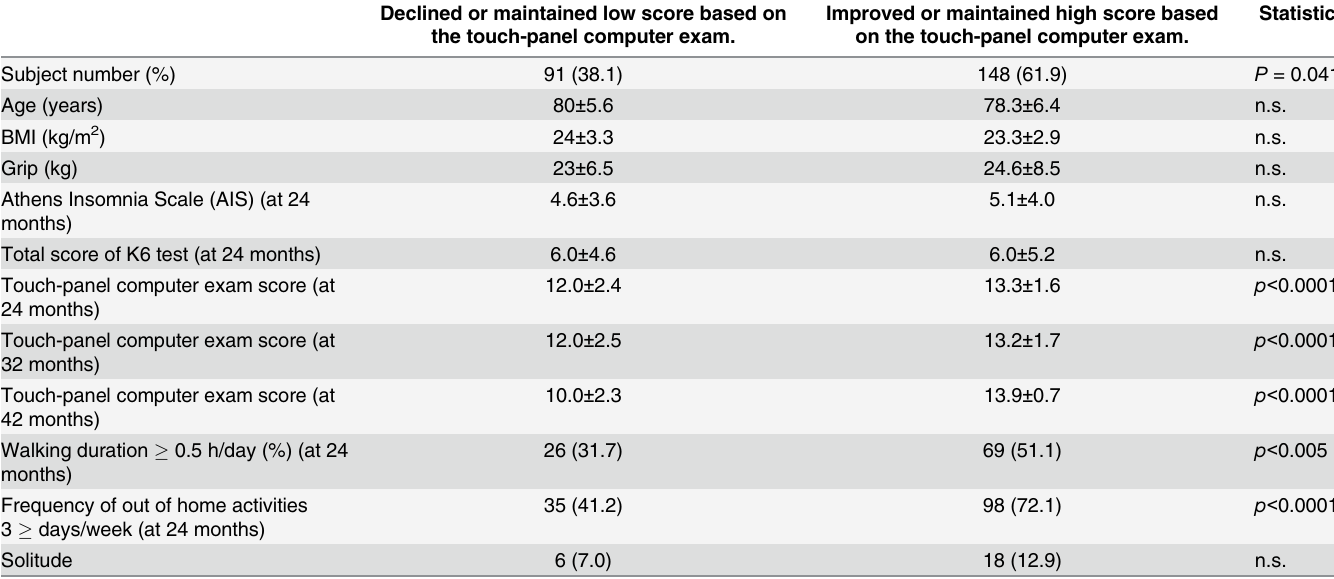
Table 2. Logistic regression analysis to identify factors independently associated to cognitive functions. Declined or maintained low score based on Improved or maintained high score based the touch-panel computer exam. on the touch-panel computer